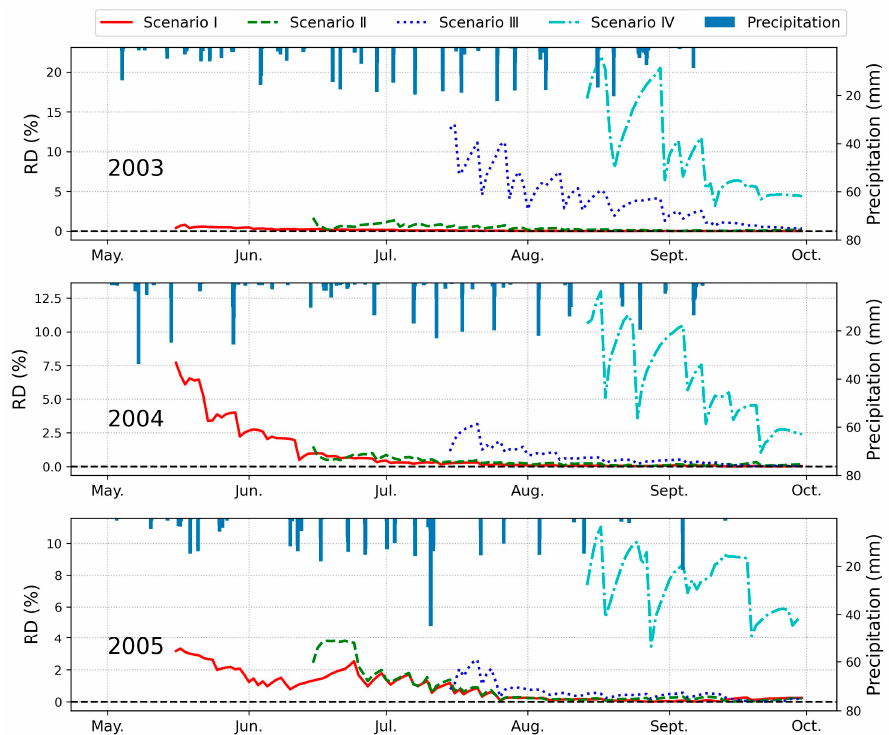
Figure 6. RD of soil moisture prediction in four scenarios over 2003–2005. The red solid lines, green dashed lines, blue dotted lines, and cyan dashed lines represent RD of scenario Ⅰ , II , Ⅲ , and Ⅳ , respectively. Blue bars are precipitation.